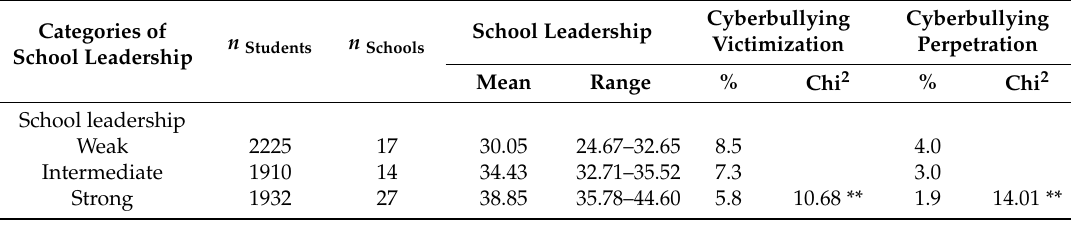
Table 2. Description of categories of school leadership, and the occurrence of cyberbullying victimization and cyberbullying perpetration by categories of school